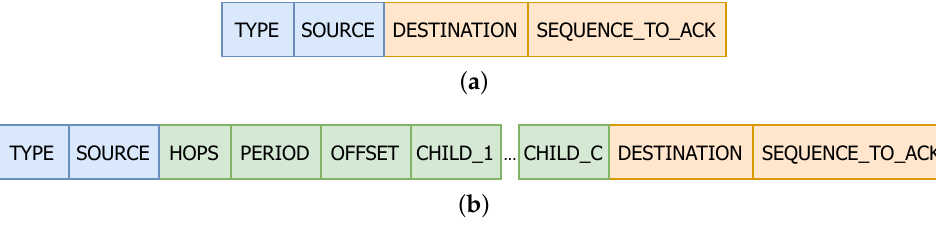
Figure 5. Format of ( a ) the ACK frame from gateway and ( b ) the ACK frame from